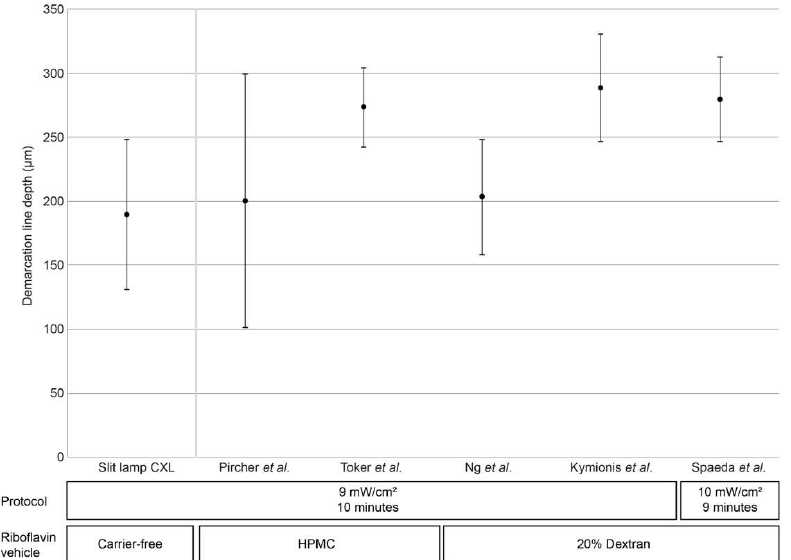
Figure 2. Demarcation line depth at after accelerated CXL (9 mW/cm² for 10 min) performed at the slit lamp and from previous publications that report CXL procedures using the similar irradiation settings (either 9 mW/cm² for 10 min [9–12] or 9 mW/cm² for 10 min) [13] with patients in a lying position. Black circles denote mean demarcation line depth, bars denote standard deviation; triangles denote maximum/minimum values (where available). HPMC, hydroxypropyl methylcellulose.